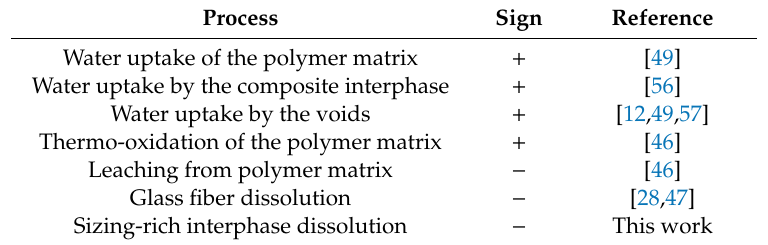
Table1. Summaryoftheprocessesduringhygrothermalagingofcompositesthata ff